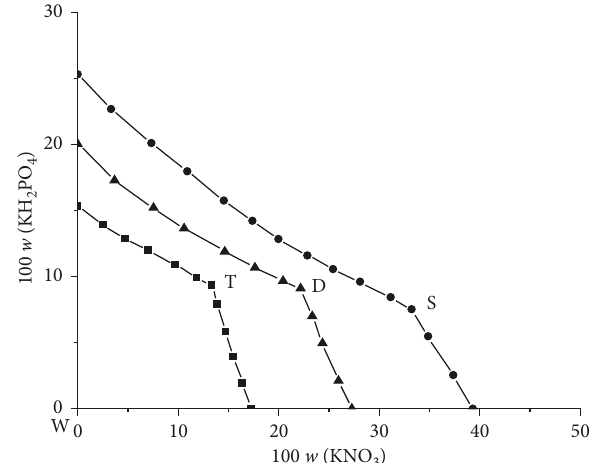
Figure 5: Solubility for the ternary system KH at 283.15, 298.15, and 313.15K. 283.15K; 298.15K; 313.15K; W, T, D, and S have the same meaning as described in Figures 2 and 3.